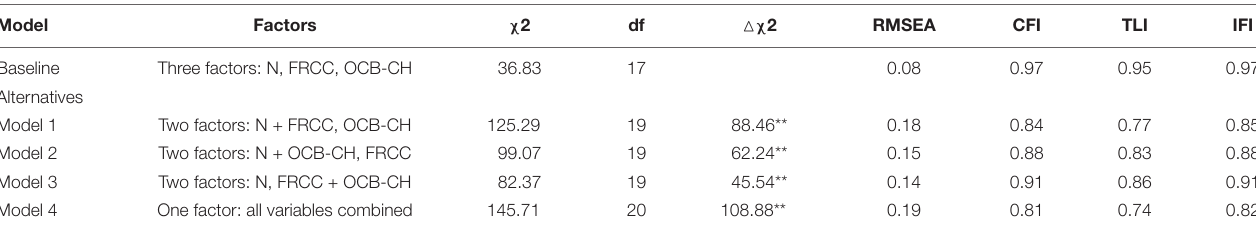
TABLE 1 | Study 1 results of confirmatory factor analysis.